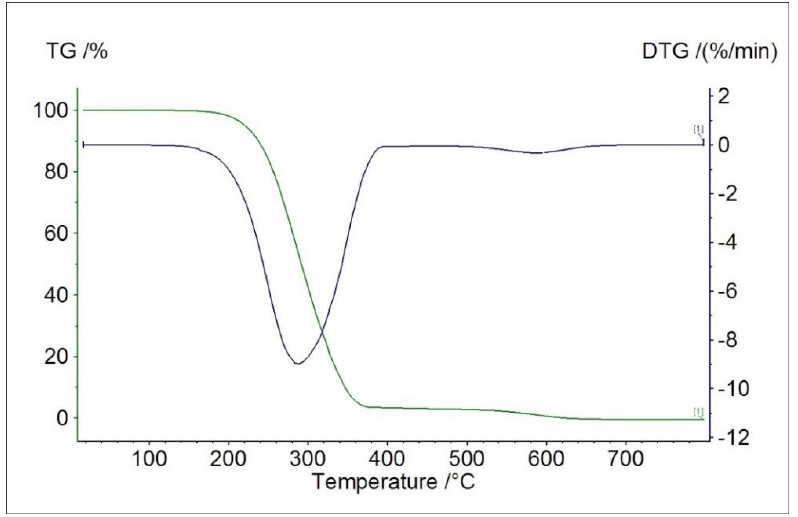
Figure 5. TG (green) and DTG (blue) curves showing ligand decomposition pattern in air. Decomposition of Cu(L)Cl 2 compound (Figure 6) begins at 160 ° C . From this temper- ature up to 500 °C, we observe two-step, partial decomposition of the organic ligand (mass loss found, 55.5%; mass loss calculated, 55.39%). Horizontal mass level appears at 740 °C. The last mass loss is connected with postcombustion processes of the organic molecule, as well as, most likely, formation of volatile copper(I) chloride polymers, which has already been reported in the literature [38].